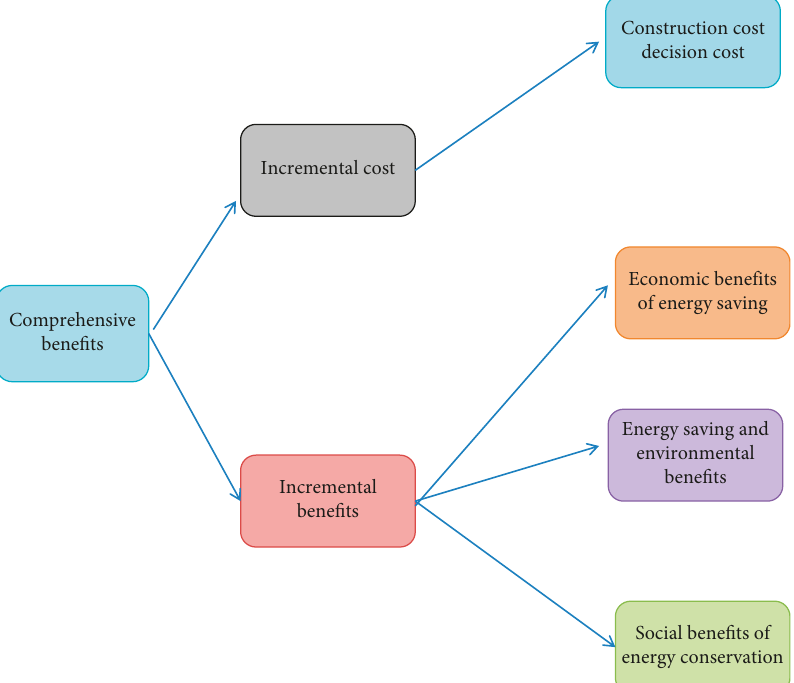
Figure 2: Framework of incremental comprehensive